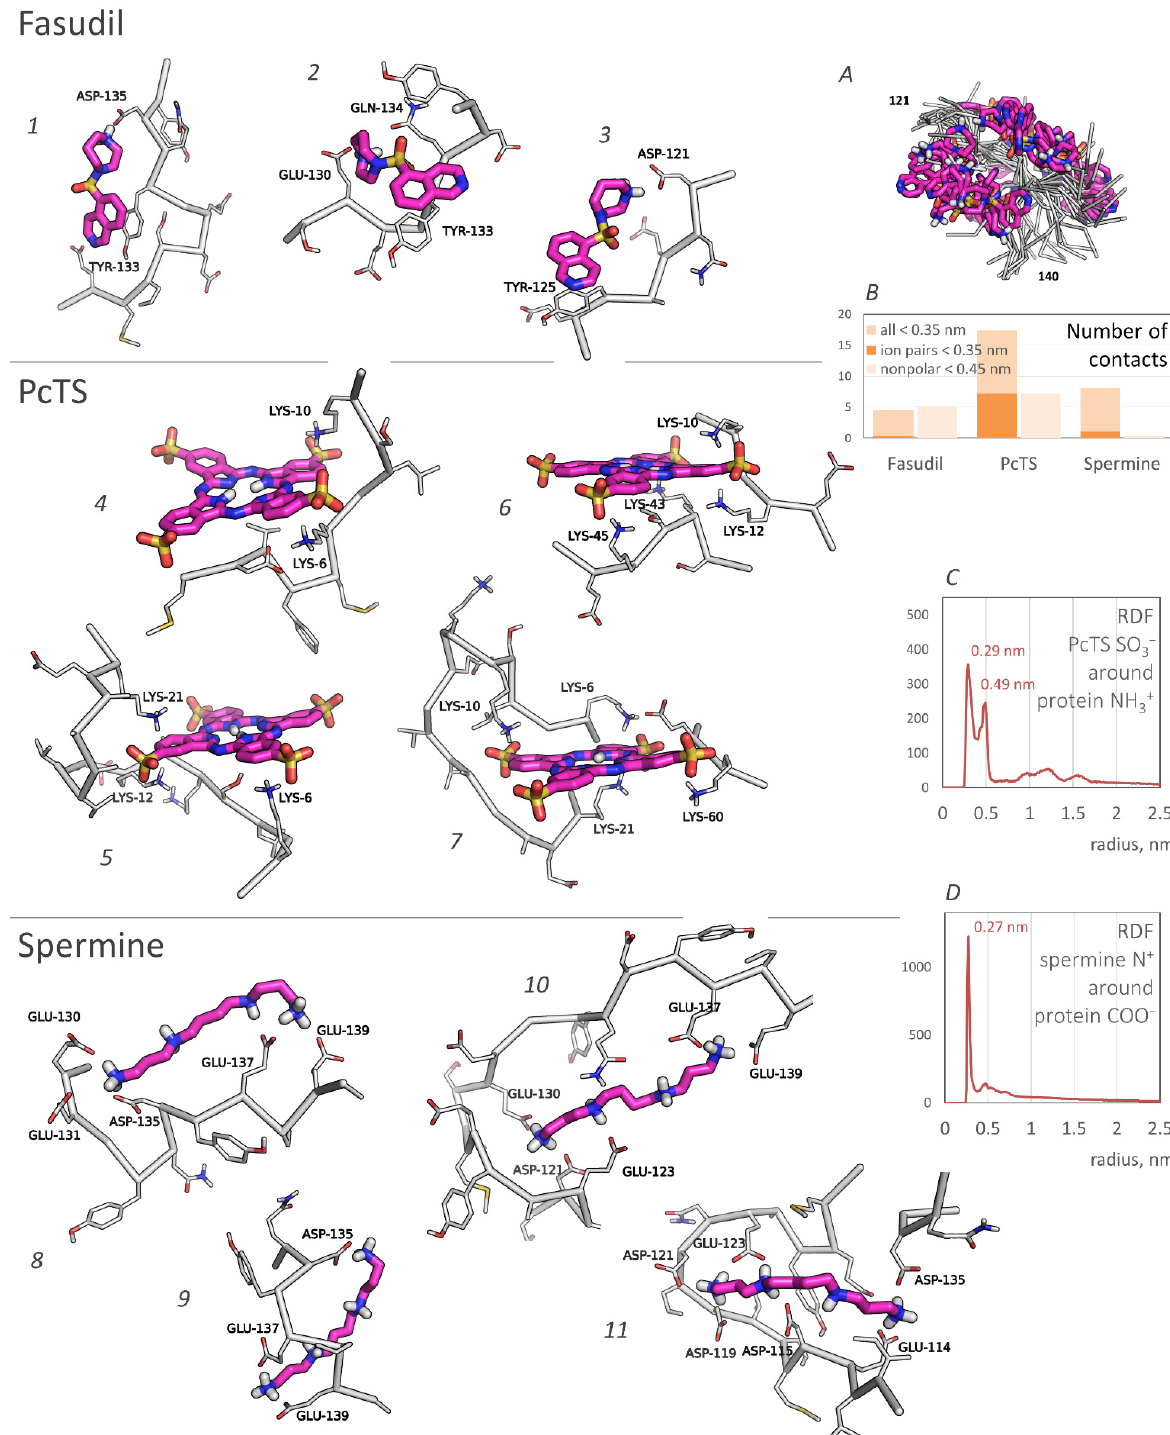
Figure 2. Typical binding poses of fasudil, PcTS, and spermine. The ligands are shown in purple; nonpolar hydrogens are hidden. The poses (1–11) are numbered for the convenience of mentioning. Inset ( A ) shows the superimposed binding poses of fasudil bound to the alpha-synuclein 133–136 region (only a backbone of the protein chain is shown); ( B ) represents a number of contacts (pairs) between the alpha-synuclein chain and the ligands; ( C , D ) represent the RDF profiles of PcTS SO 3 − groups (specifically, oxygen atoms) around the positively charged amino groups of alpha-synuclein ( B ) and the positively charged amino groups of spermine around the carboxyl groups of